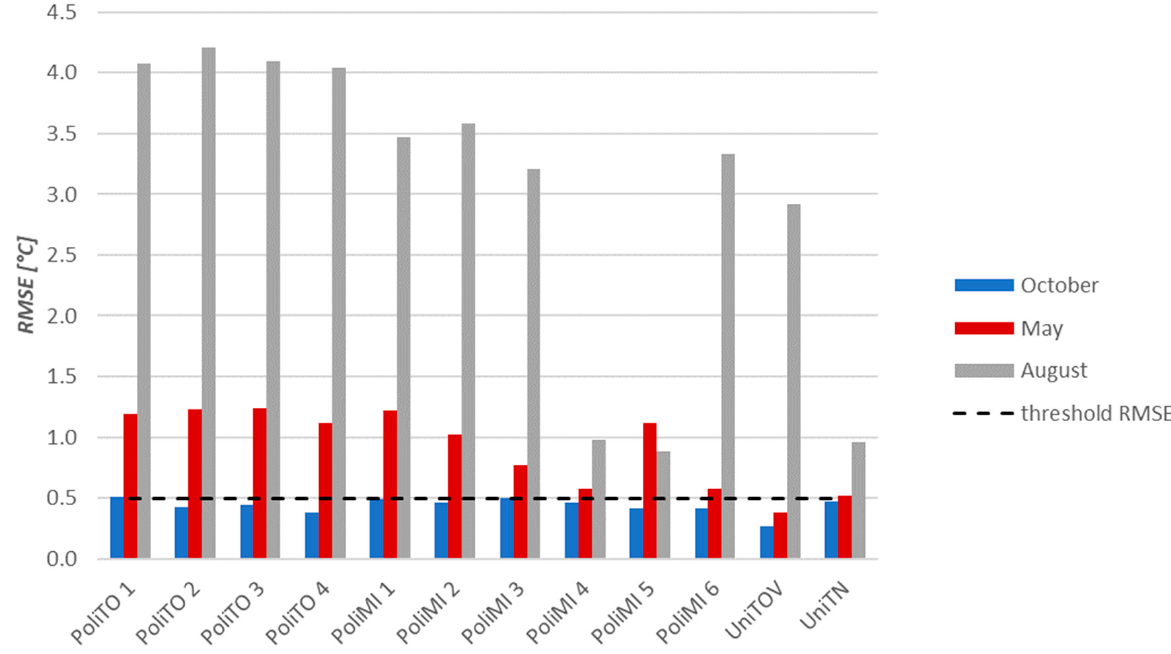
Figure 8. Performance of the calibrated models in the validation periods.